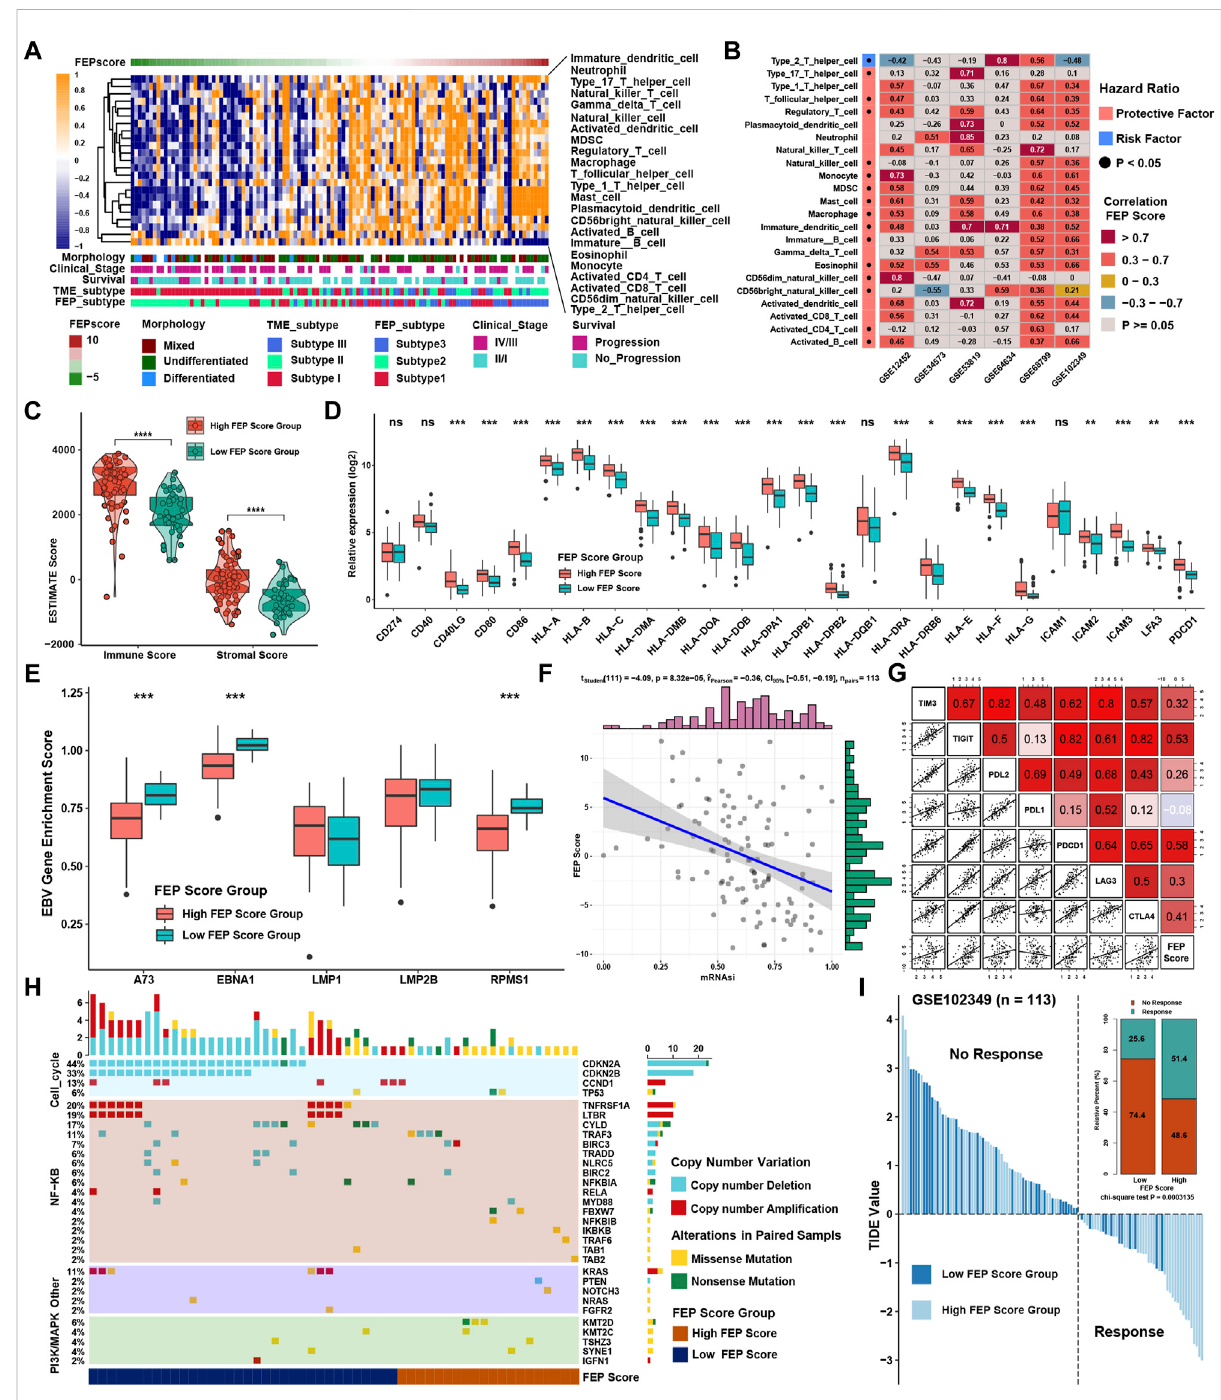
FIGURE 5 Role of FEP score in immunotherapy for NPC. (A) Correlations between FEP score and the immune cell in fi ltrations in NPC using Spearman analysis. Positive and negative correlations were marked with orange and blue, respectively. (B) Correlations between FEP score and TME in fi ltration in six independent NPC datasets using Spearman analysis. (C) ESTIMATE ps. (D) The relative expression of costimulatory, MHC, and adhesion moleculesindifferentFEPscoregroups. (E) EBVgeneenrichmentscorebyGSVAindifferentFEPscoregroups. (F) Correlationanalysisbetween FEP score and mRNAsi using Spearman analysis. (G) Correlation analysis between FEP score and immune checkpoint inhibitors in GSE102349 using Spearman analysis. (H) Somatic copy number variations and mutations in the paired NPC cohort in GSE102349 were shown in different FEP score groups. (I) TIDE value of NPC samples in GSE102349 in different FEP score groups. The chi-square test was used to calculate statistical differences. The asterisks represented p values (* p < 0.05; ** p < 0.01; *** p < 0.001) and ns represented no signi fi